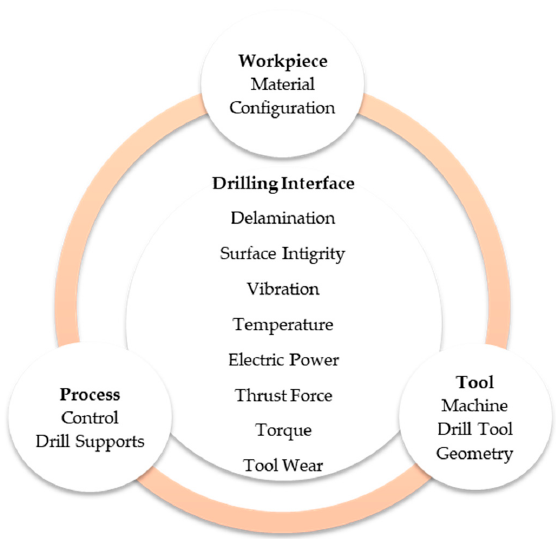
Figure 1. Elements involved in machining process.